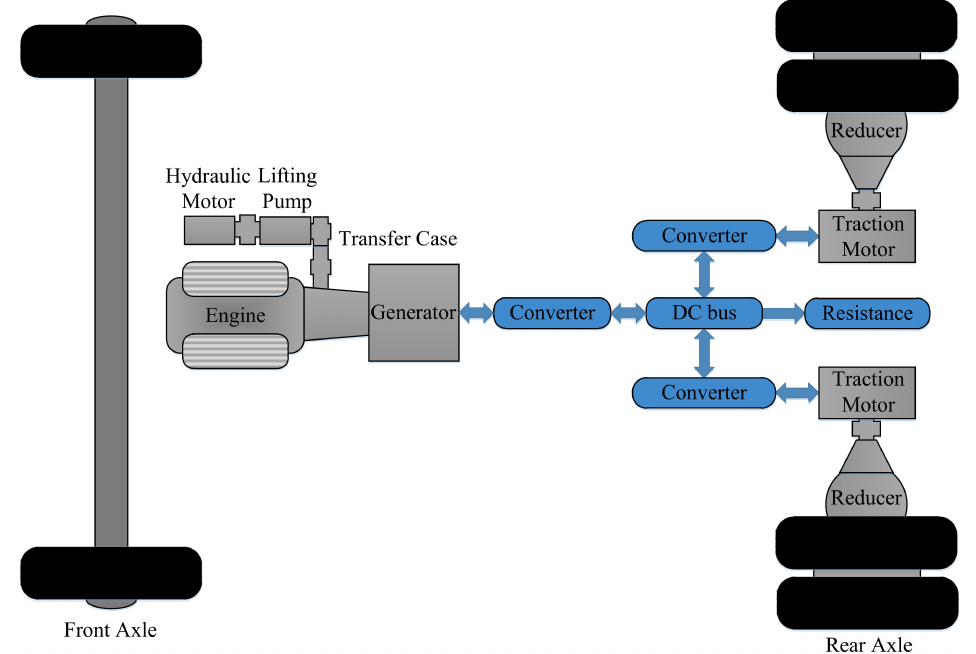
Figure 4. Powertrain of the hydro-pneumatic hybrid electric-drive mining